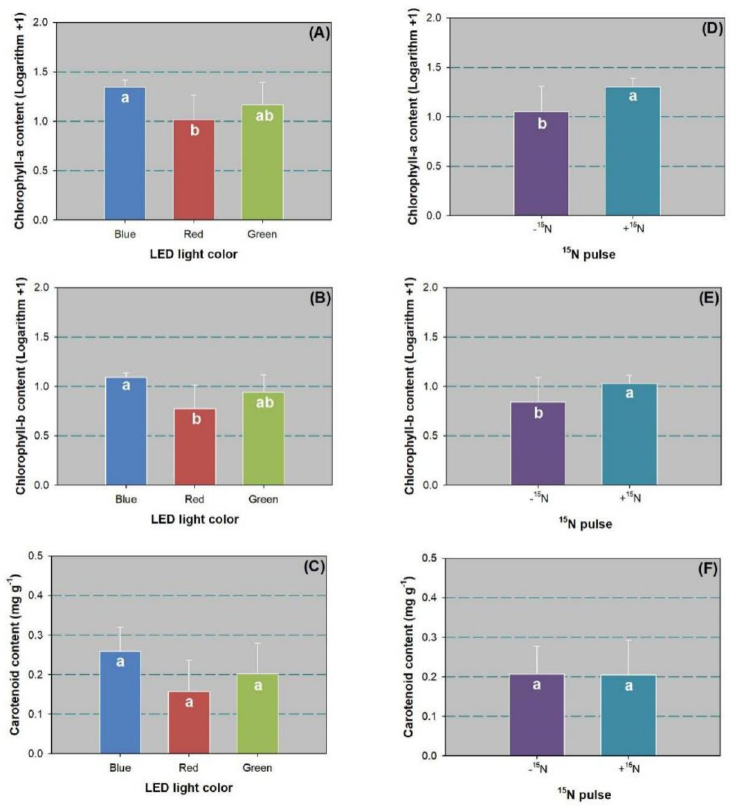
Fig 2. Contents of chlorophyll-a (A,D), chlorophyll-b (B,E), and carotenoid (C,F) in leaves of Chinese cork oak ( Quercus variabilis Blume) seedlings subjected to blue, red, and green LED spectra ( n = 24 seedlings per replicate) or subjected to N pulse at 120 mg 15 N plant -1 (+ 15 N) or zero (- 15 N) ( n = 36). Data that failed to follow a normal distribution were transformed by logarithm plus 1.0. Columns and bars represent means and standard errors, respectively. Different letters denote a significant difference according to Tukey’s test at the 0.05